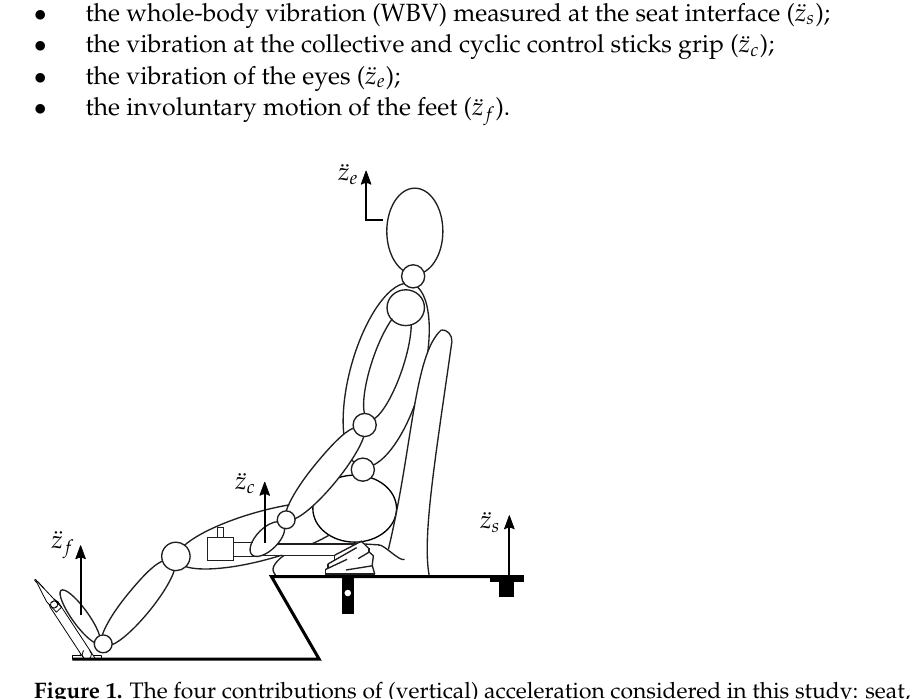
Figure 1. The four contributions of (vertical) acceleration considered in this study: seat, ¨ z s ; grip of collective stick, ¨ z c (cyclic stick not shown); pilot’s eyes, ¨ z e , and feet, ¨ z f